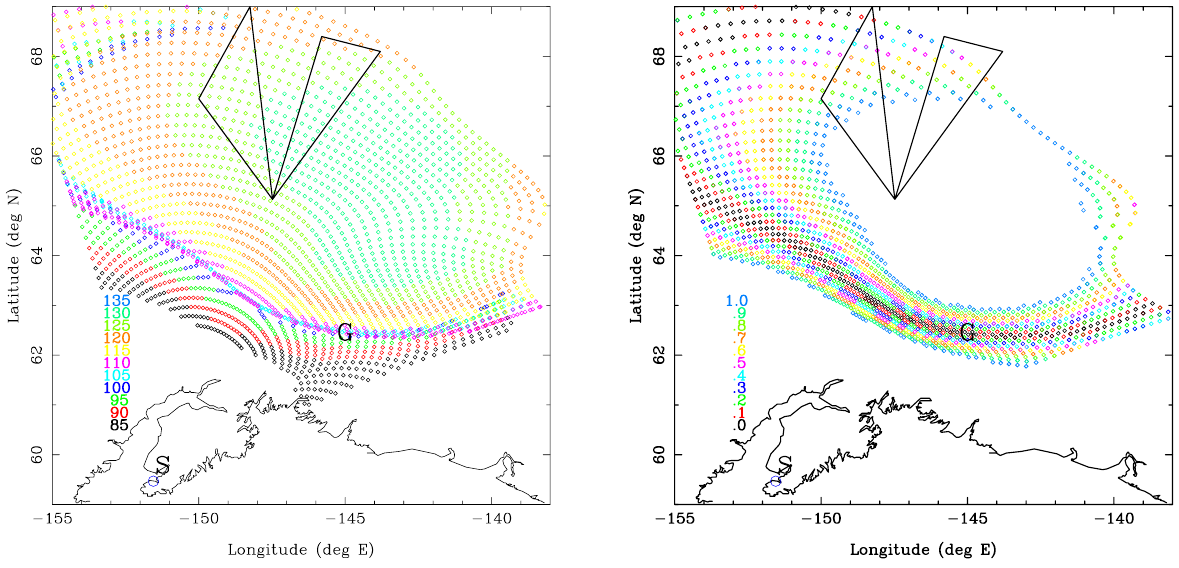
Fig. 1. Raytracing calculation for 30MHz radar signals emanating from the KBL site near Seldovia, Alaska (plotter symbol “ S ”). Left panel: altitude of the locus of perpendicularity in km. Right panel: magnetic aspect angle at an altitude of 110km in degrees. The Gakona site is indicated by the plotter symbol “ G ”. The triangles represent flight corridors for the Poker Flat Rocket Range, which are shown as an indication of scale.